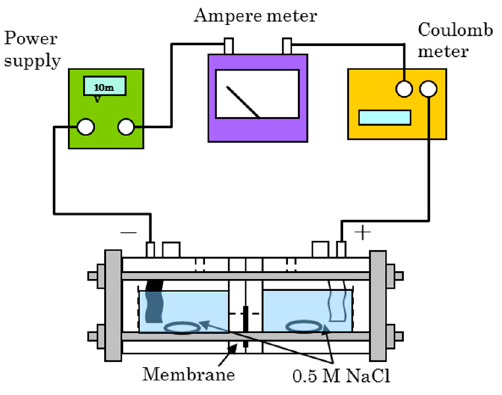
Figure 2. Apparatus for the electrodialysis experiments. The effective area of the cell was 4.0 cm 2 .